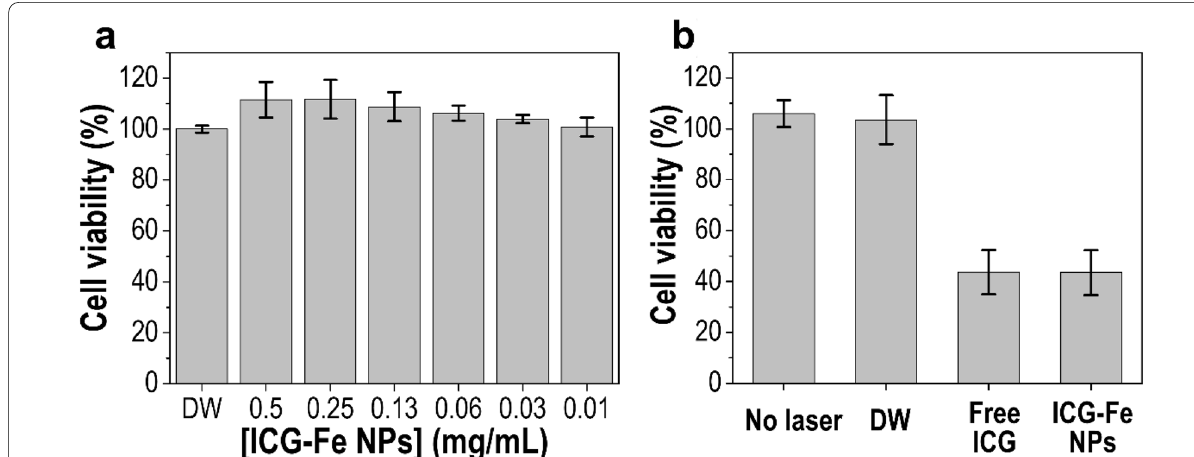
Fig. 5 a In vitro dark toxicity of ICG‑Fe NPs against HT‑29 cells incubated at various concentrations for 24 h. b In vitro phototoxicity of DW, free ICG (0.375 mg/mL), and ICG‑Fe NPs (0.5 mg/mL) under 785 nm laser irradiation (5 min, 1 W). The data are shown as the mean